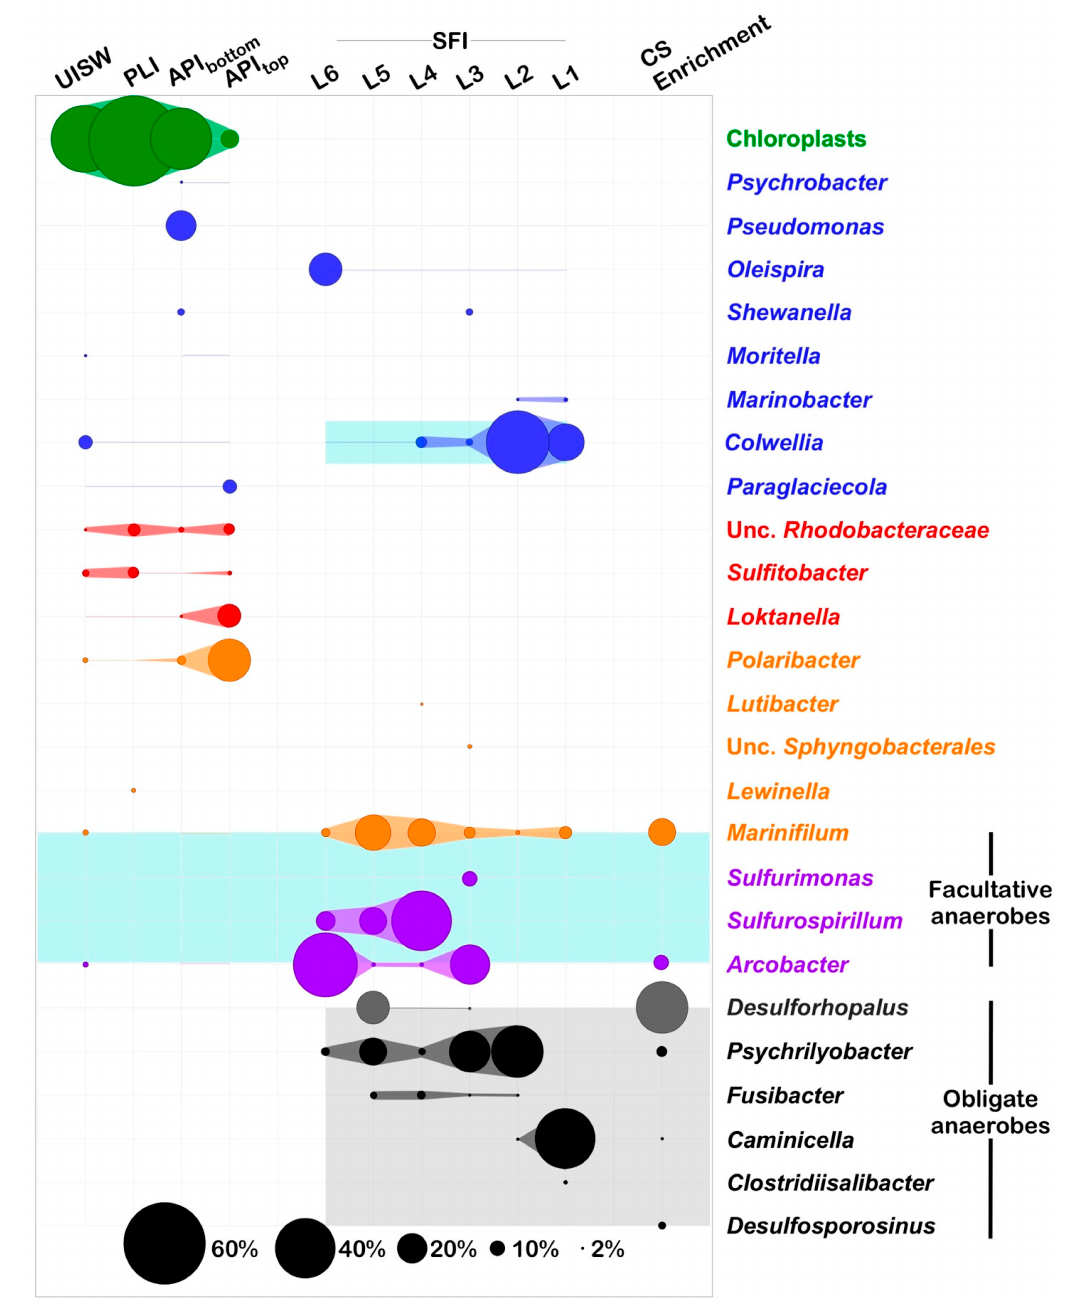
Figure 4. Relative abundances of bacterial genera and chloroplast-related SSU rDNA genes identified in microbial communities associated with Antarctic sea-ice, in simulated fast ice, and in anaerobic enrichment decomposing compatible solutes (CS Enrichment). The taxonomy is based on SILVAngs, release 123.1. Sequence abundances are given in percentage of total number of classified reads. Only taxa that made up >2% of the total sequences in any given sample are shown. The abbreviations used are similar to those shown in Figures 2 and 3. A list of the identified genera and their relative abundances in CS Enrichment is reported in Table